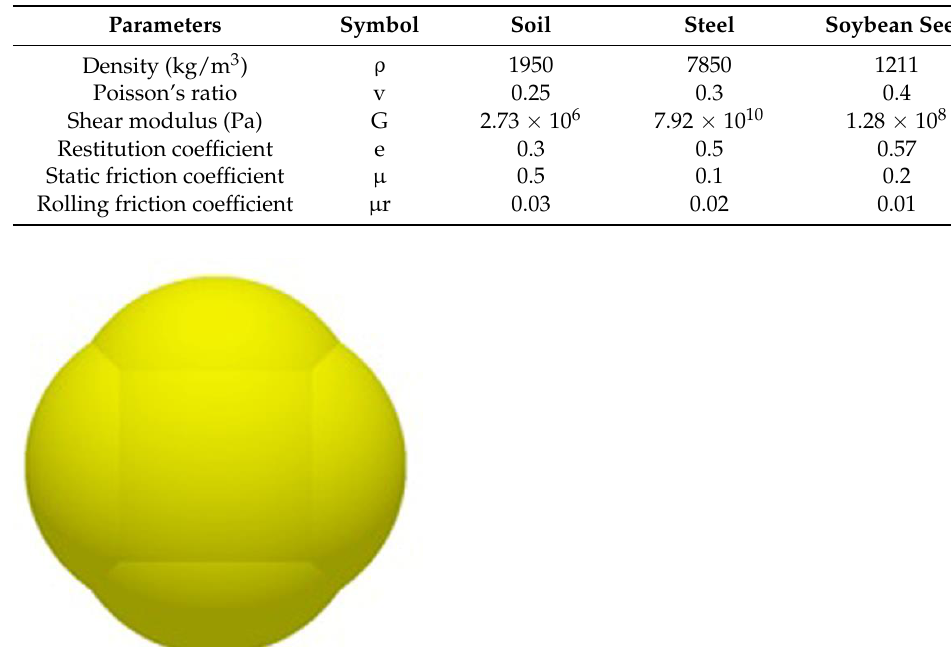
Table 3. The detailed parameters in the simulation.